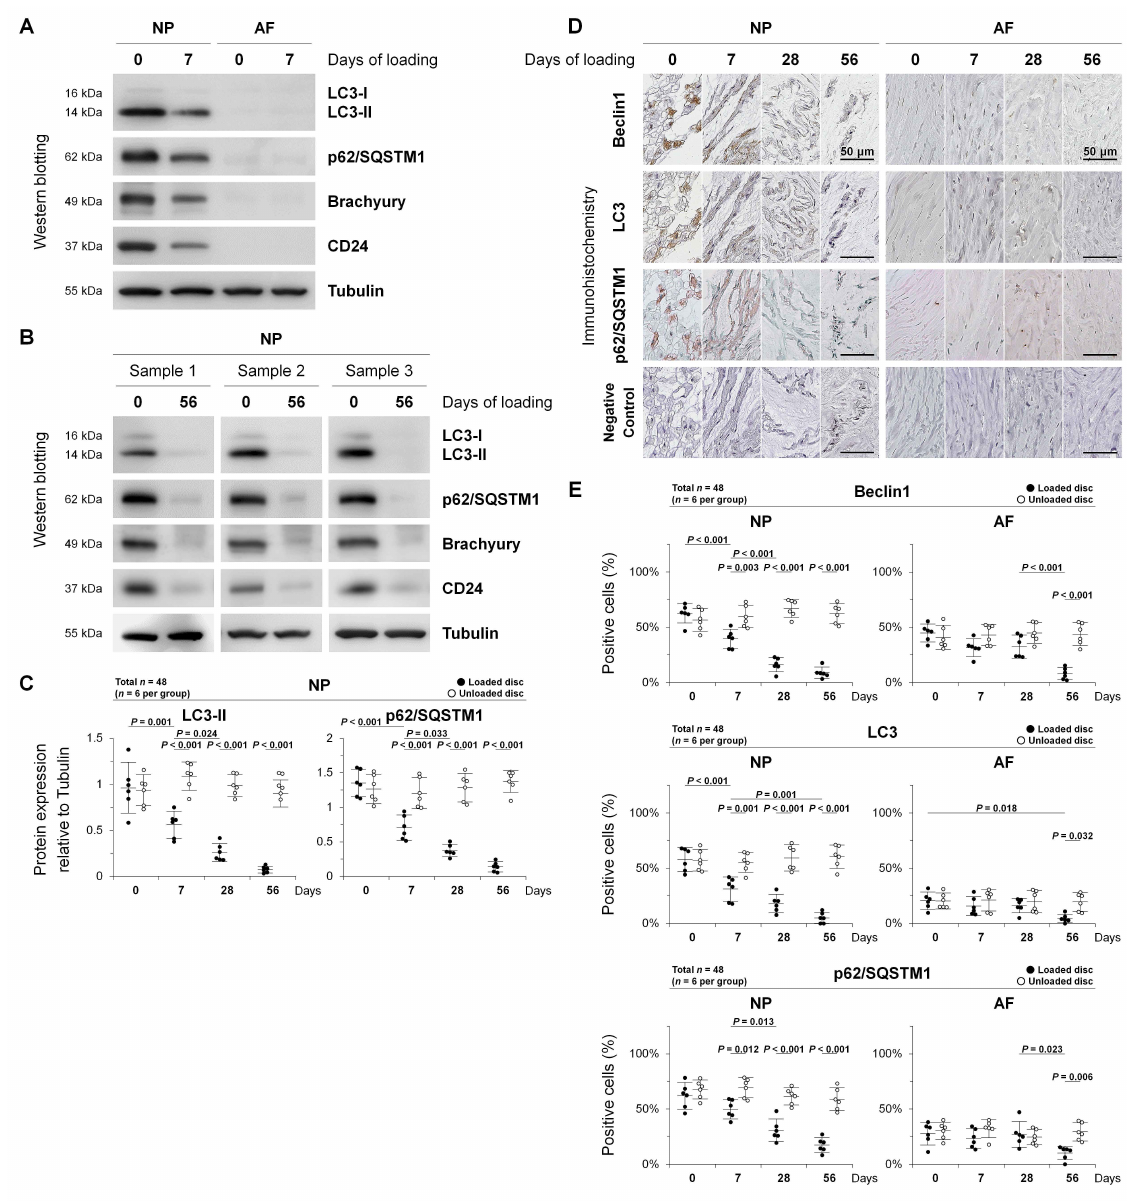
Figure 3. Autophagy in rat tail sustained static compression-induced disc degeneration. ( A ) Time-course Western blotting for autophagy marker LC3, autophagy substrate p62/SQSTM1, and NP notochordal markers brachyury and CD24 in total protein extracts from rat tail loaded disc NP and AF tissues at 0-day (sham) and 7-day sustained static compression. Tubulin was used as a loading control. Immunoblots shown are representative of experiments with similar results ( n = 6). ( B ) Time-course Western blotting for autophagic LC3 and p62/SQSTM1 and loading control tubulin in rat tail loaded disc NP tissue protein extracts at 0-day (sham) and 56-day sustained static compression. Immunoblots shown are three representatives of experiments with similar results ( n = 6). ( C ) Changes in protein expression of LC3-II and p62/SQSTM1 relative to tubulin in rat tail loaded and unloaded NP tissue protein extracts at 0-day (sham), 7-day, 28-day, and 56-day sustained static compression. Data are the mean ± 95% CI. Two-way ANOVA with the Tukey–Kramer post-hoc test was used ( n = 6). ( D ) Time-course immunohistochemistry for autophagy-related beclin1, LC3, p62/SQSTM1, and negative control in rat tail loaded disc NP and AF sections at 0-day (sham), 7-day, 28-day, and 56-day sustained static compression. Immunoimages shown are representative of experiments with similar results ( n = 6). ( E ) Changes in the percentage of beclin1-positive cells, LC3-positive cells, and p62/SQSTM1-positive cells in rat tail loaded and unloaded disc NP and AF sections at 0-day (sham), 7-day, 28-day, and 56-day sustained static compression. Data are the mean ± 95% CI. Two-way ANOVA with the Tukey–Kramer post-hoc test was used ( n =